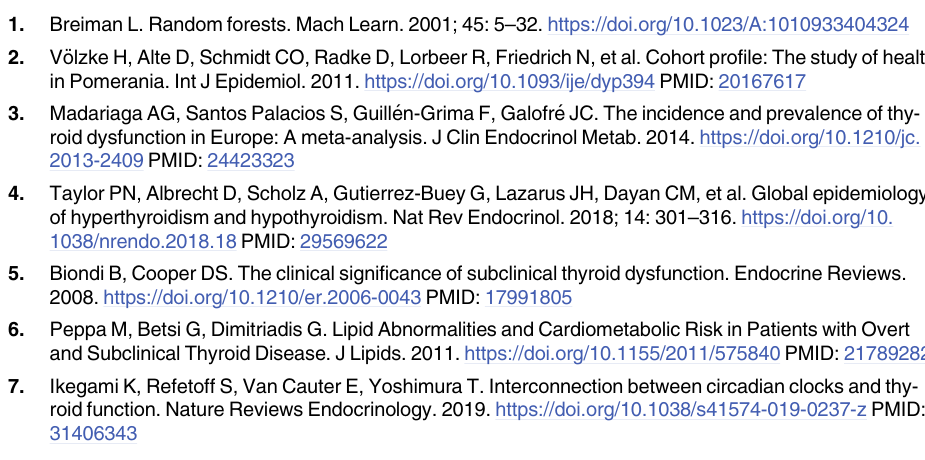
S3 Table. R Software packages and